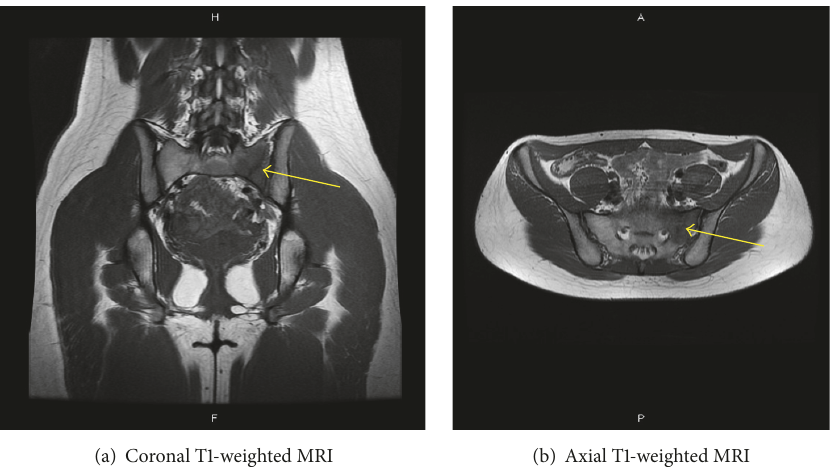
Figure 1: T1-weighted MRI scan shows a linear area of decreased signal intensity of the left sacrum with surrounding a T1 hypointense area (arrow).